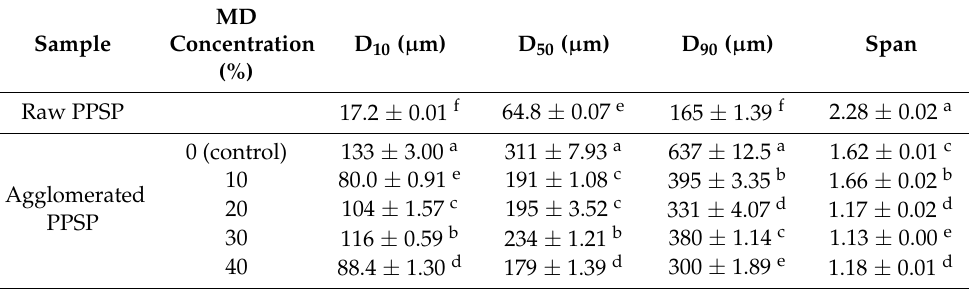
Table 1. Particle size distribution (PSD) of raw and agglomerated PPSPs with different concentrations of MD binder.